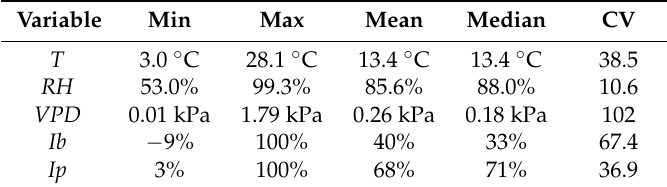
Table 2. Descriptive statistics (minimum, maximum, mean, median and coefficient of variation (CV)) for average air temperature ( T ), average relative humidity ( RH ), vapour pressure deficit ( VPD ) and rainfall interception by birch ( Ib ) and pine ( Ip )